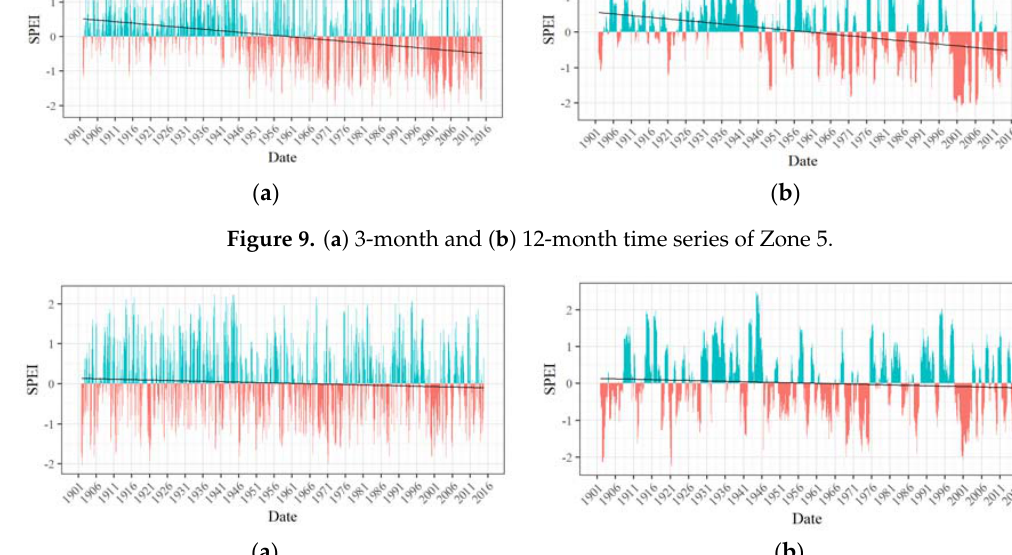
Figure 10. ( a ) 3 ‐ month and ( b ) 12 ‐ month SPEI time series of Zone 6.